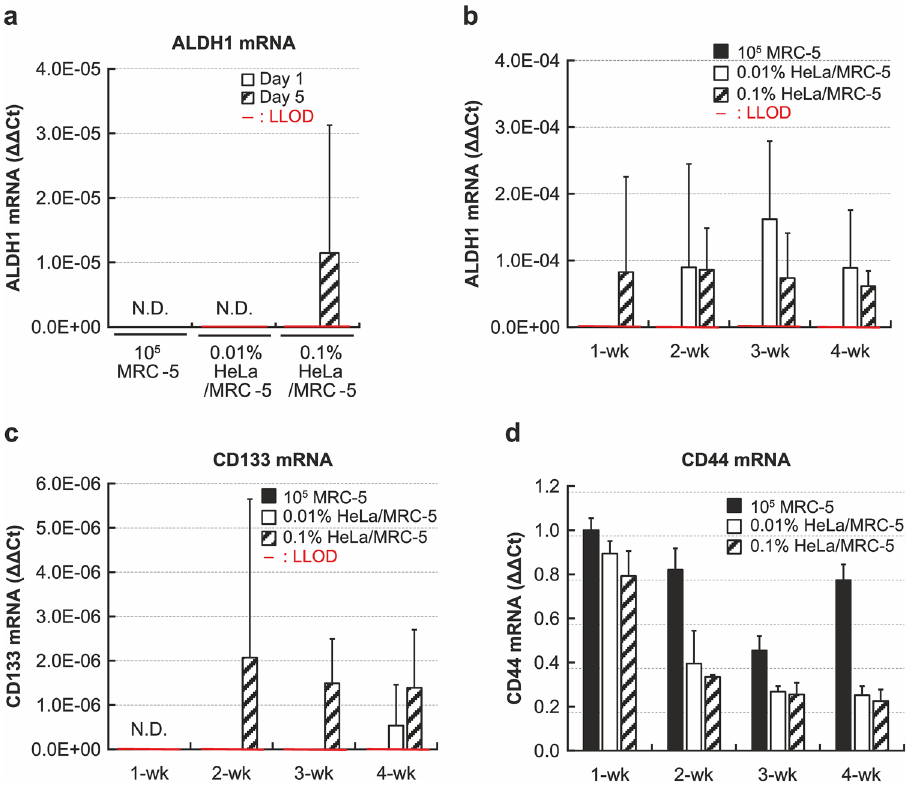
Figure 5. The changes in the cancer stem cell markers in the short and long-term culture. The mRNA expressions in soft agar of the short- and long-term culture. ( a ) The expression of ALDH1 mRNA in the short- term culture, ( b ) The expression of ALDH1 mRNA in the long-term culture, ( c ) The expression of CD133 mRNA in the long-term culture, ( d ) The expression of CD44 mRNA in the long-term culture. The LLOD of CD44 mRNA was not calculated because its expression in the MRC-5 alone group was much higher than the groups containing HeLa cells. Bars represent means ± SD. n = 3 samples. The LLOD is set as mean expression of MRC-5 at each week ± 3.3 × SD. ALDH1, aldehyde dehydrogenase